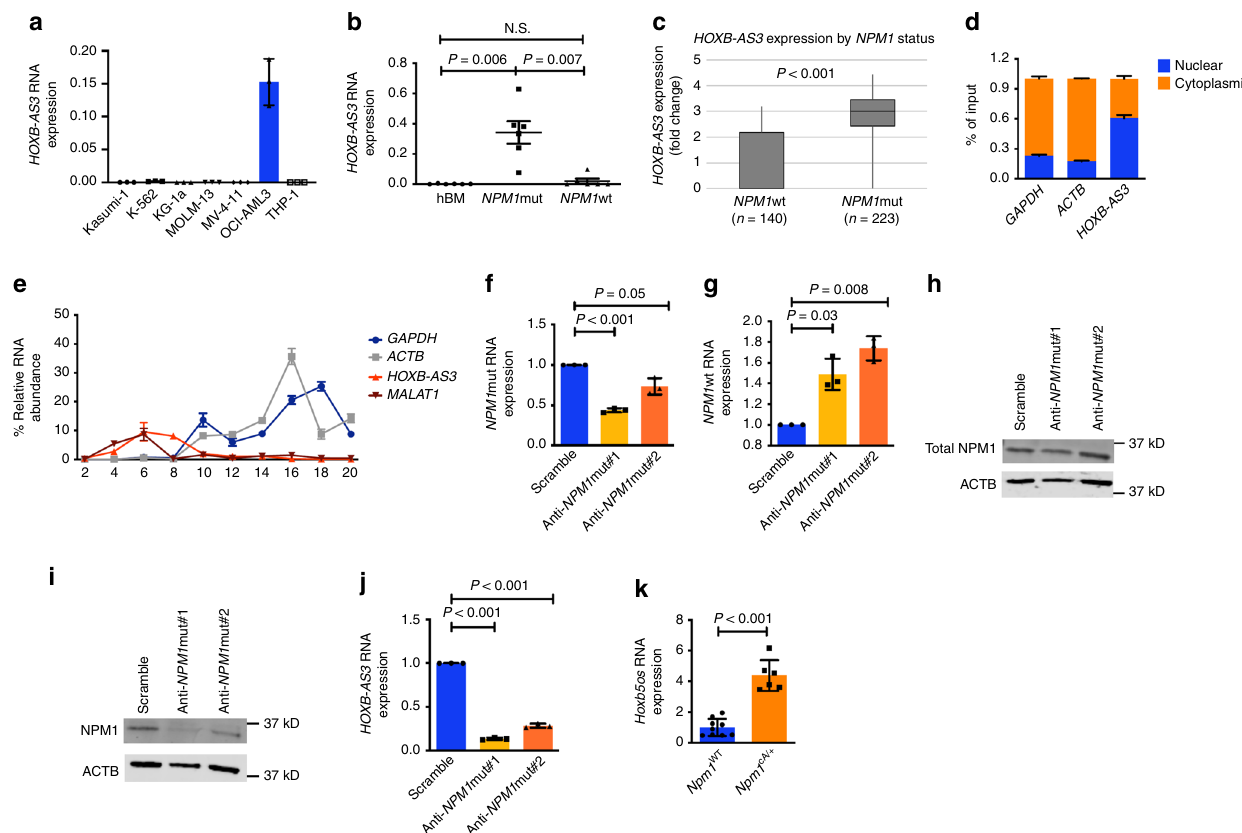
Fig. 1 HOXB-AS3 lncRNA expression in healthy hematopoietic cells and leukemic blasts. a Relative RNA expression of HOXB-AS3 in seven AML cell lines. b Relative HOXB-AS3 RNA expression in bone marrow (BM) samples from six healthy donors (hBM), AML blasts from six patients with NPM1 mut, and AML blasts from six patients with NPM1 wt, in aggregate. N.S., not signi fi cant. c HOXB-AS3 RNA expression (depicted as fold change) in younger adult CN- AML patients with NPM1 wild-type ( NPM1 wt; n = 140) and in those with mutated NPM1 ( NPM1 mut; n = 223). d Nuclear versus cytoplasmic localization of GAPDH , ACTB mRNA, and HOXB-AS3 RNA in OCI-AML3 cells. e Targeted pro fi ling of GAPDH , ACTB , HOXB-AS3 , and MALAT1 in OCI-AML3 cells in non- polysome associated (fractions 1 – 6), 40S, 60S, 80S (fractions 7 – 11), as well as low (fractions 12 – 15) and high (fractions 16 – 20) molecular weight polysomal fractions, isolated via glucose gradient centrifugation. f – k OCI-AML3 cells treated with scramble versus NPM1 mut-targeting gapmers (anti- NPM1 mut#1 and anti- NPM1 mut#2). f Relative NPM1 mut mRNA, g relative NPM1 wt mRNA, h total NPM1 protein, i NPM1mut protein, and j relative HOXB- AS3 RNA expression in the treated cells. In the presented western blots ( h , i ), ACTB is also visualized as loading control. k Relative Hoxb5os RNA expression in BM samples from three Npm1 WT and two Npm1 cA/ + mice. Unless otherwise stated all samples were analyzed in technical triplicates. P values were calculated using paired two-sided t -tests. In the fi gures, heights of boxplots indicate mean values with standard deviation. Error bars indicate highest and lowest values in each population. Source data are provided as a Source Data fi harboring a humanized, mutated Npm1 knock-in allele ( Npm1 cA/ + ) of HOXB-AS3 ( P < 0.001) and an increase in the G2/M phase cells and age-matched wild-type controls ( Npm1 WT ), as previously compared with scramble control ( P = 0.006 ; Fig. 2b, c). Annexin described 16 . Npm1 cA/ + mice harbor a four-nucleotide insertion that corresponds to the Type A NPM1 mutations that are detected in human AML samples. We measured the expression (Supplementary Fig. 4a, b). Colony formation unit (CFU) assays levels of a murine lncRNA transcript, which is antisense to in methylcellulose-based media showed a decrease in the colony- the Hoxb5 and Hoxb6 genes and displays sequence homology forming capacity of OCI-AML3 cells after HOXB-AS3 KD ( P = to the human HOXB-AS3 , named Hoxb5os . We found Hoxb5os to 0.02; Fig. 2d). be signi fi cantly upregulated in the Npm1 cA/ + mice, compared In contrast, overexpression of HOXB- AS3 in K-562 cells ( P = with the Npm1 WT controls ( P < 0.001; Fig. 1k). 0.001; Fig. 2e) led to an increase in the fraction of the proliferating blasts ( P = 0.02; Figs. 2f and g), with a concomitant decrease in the fraction of cells in the G0/G1 phase ( P = 0.008). Taken together, these data indicate the regulatory effect of HOXB-AS3 expression levels on the proliferative capacity of leukemic blasts.